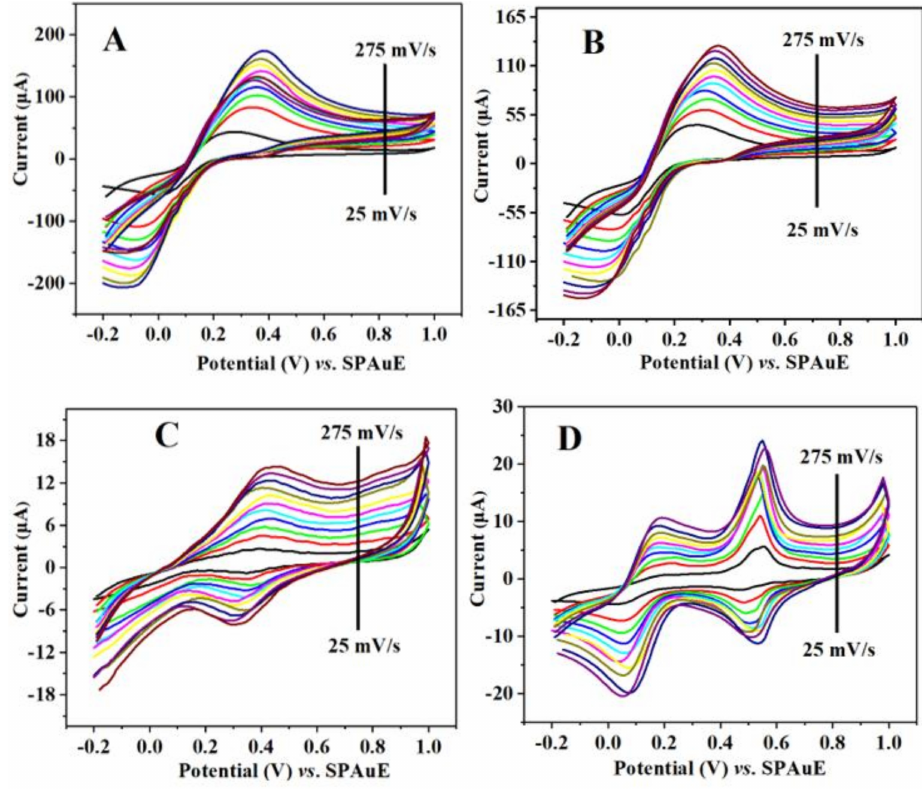
Figure 6. Cyclic voltammogram at scan rate ranging from 25 to 275 mV/s of 5 mM K 3 [Fe(CN) 6 ] in 0.1 M PBS for ( A ) SPAuE ( B ) SPAuE-CuO ( C ) SPAuE-SPEEK, and ( D )